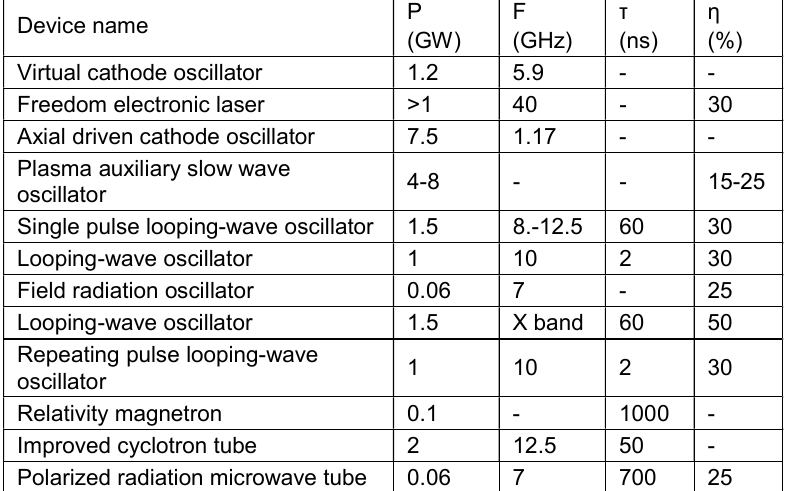
Table 1 – Different sources of HF energy Таблица 1 – Различные источники ВЧ